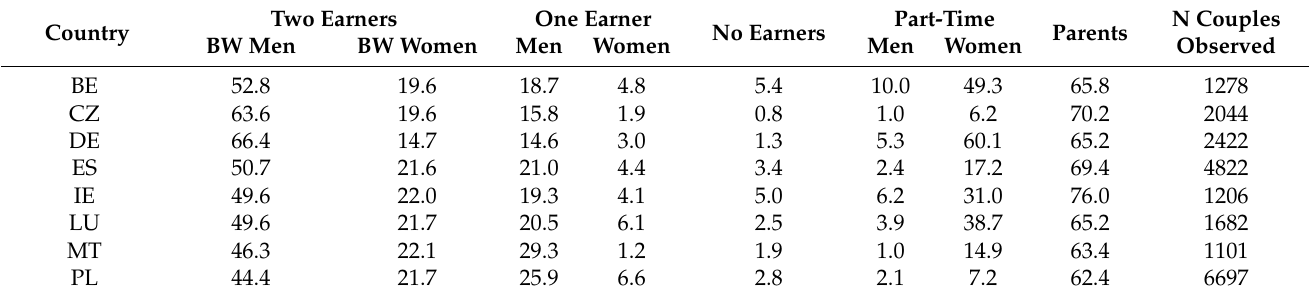
Table 2. Summary statistics of the labour market characteristics of married couples of working age (in %).